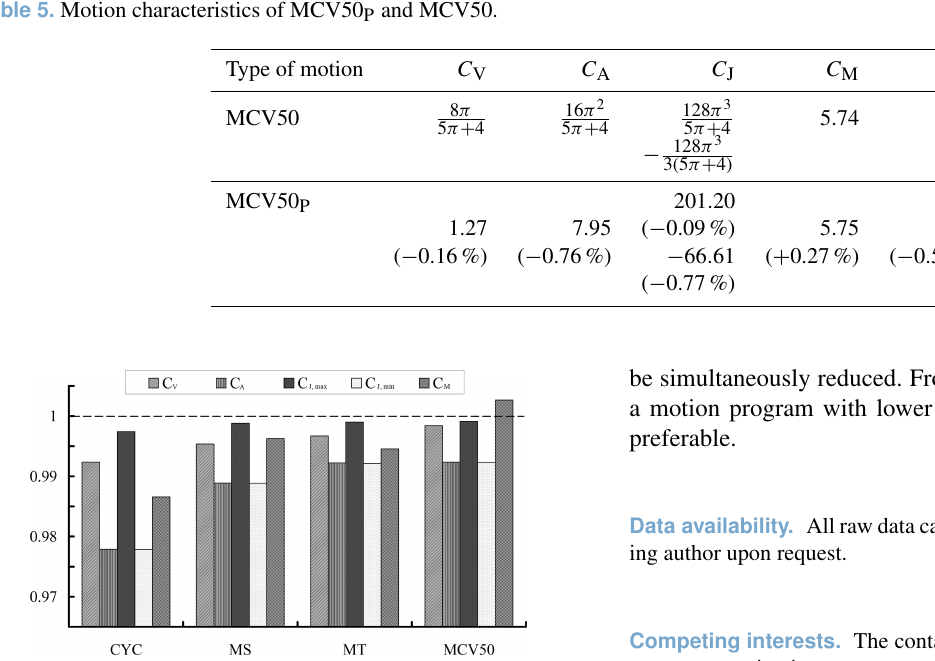
Table 5. Motion characteristics of MCV50 P and MCV50.